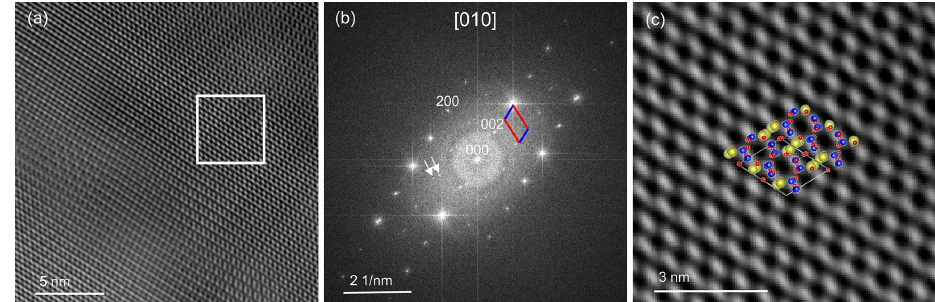
Figure 9. (a) High-resolution TEM images of labradorite along the [010] direction. The intensity is modulating because of an increase in sample thickness throughout the image. The image is filtered with the cell with a doubled c axis from its FFT, which is displayed in (b) . The a ∗ and c ∗ axis are shown in the FFT in red and blue, respectively. The white arrows indicate satellite reflections. (c) Magnified top-right area (boxed region) of the filtered HRTEM image from (a) . The labradorite structure correlates well with the high-resolution structure. Si and Al are displayed in blue, Na and Ca in yellow, and O in